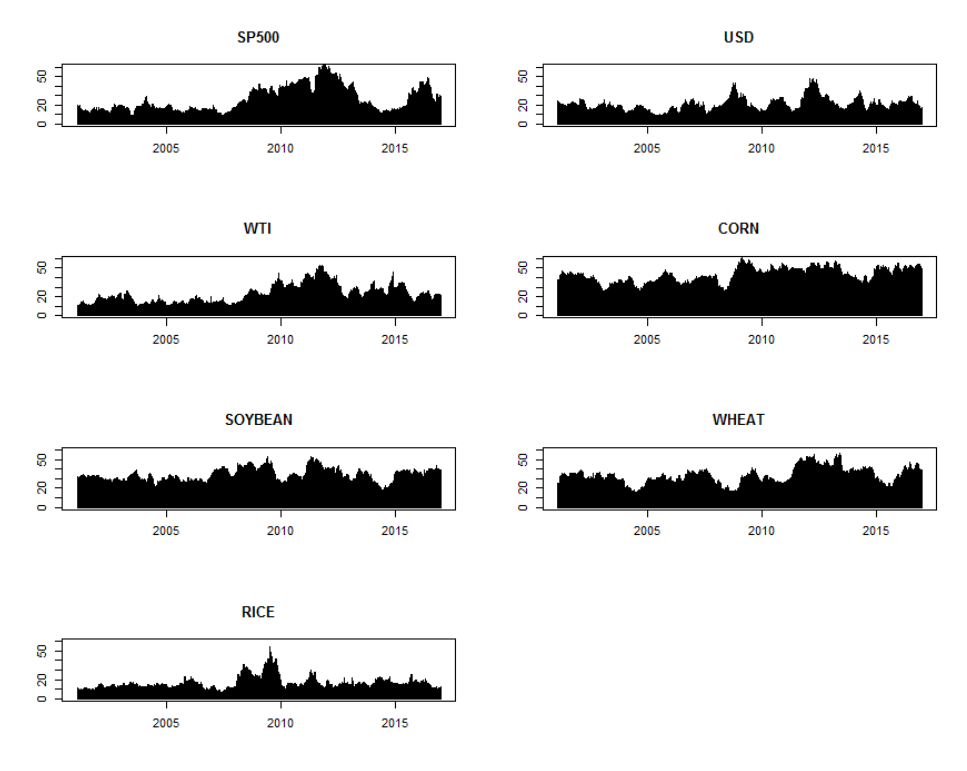
Figure 2A: Directional volatility spillovers,TO seven markets (the OLS